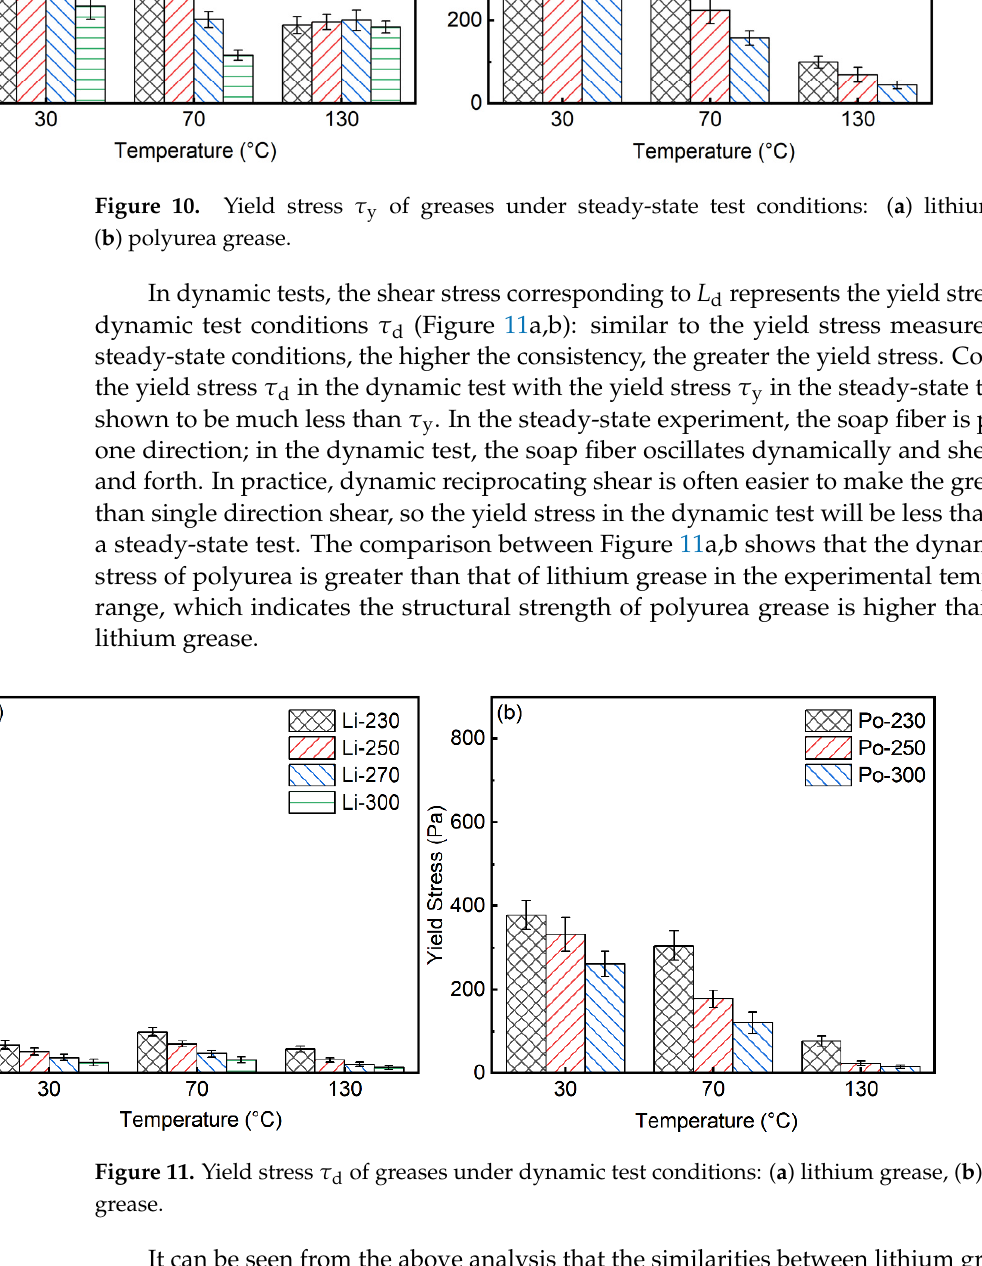
Figure 11. Yield stress τ d of greases under dynamic test conditions: ( a ) lithium grease, ( b ) polyurea grease.